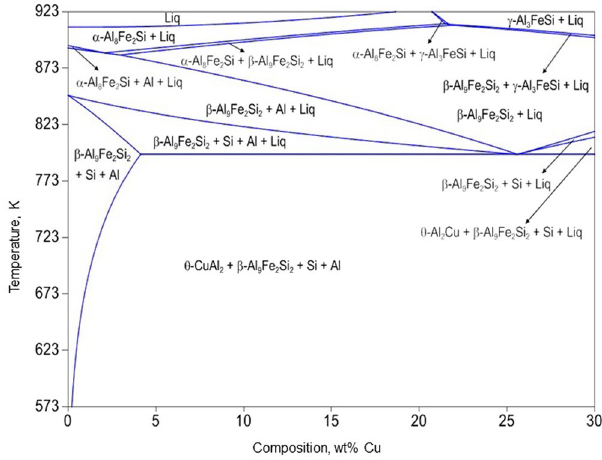
Figure 1. Computed isopleth at a section of 6 wt% Si-2 wt% Fe. Note the absence of ω -Al 7 Fe 2 Cu phase under equilibrium condition upto 30 wt%